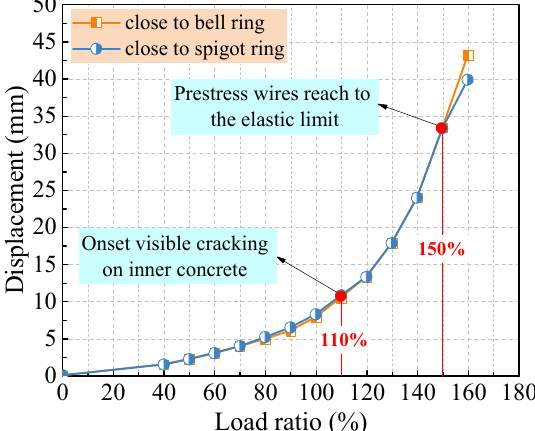
Figure 15. The displacement at the crown of the pipe changed with the load.